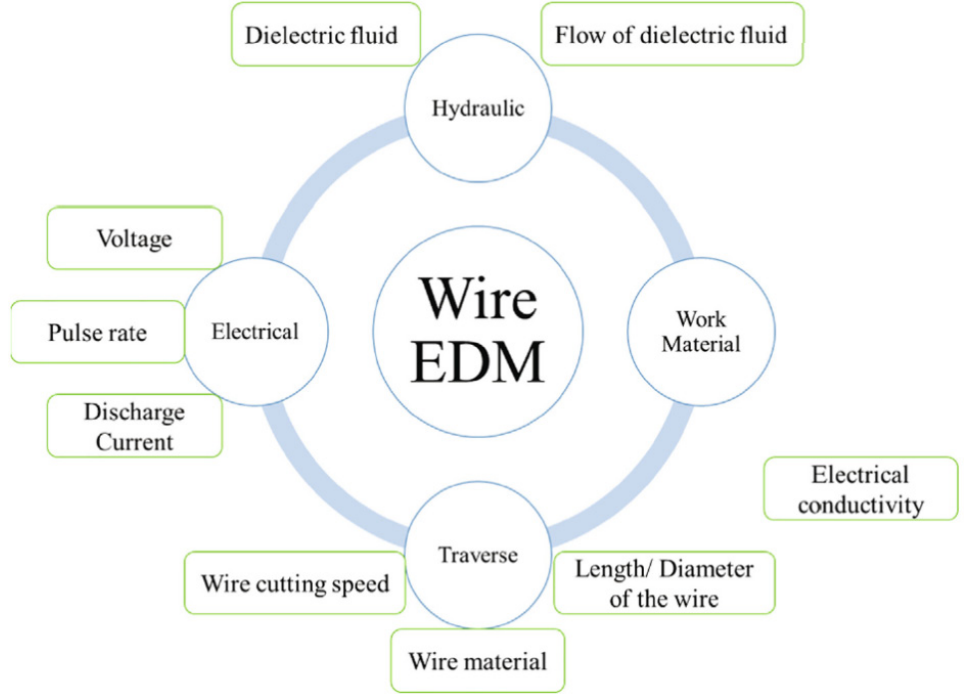
Figure 7. Parameters affecting WEDM (Reprinted with permission from Ref. [104]; 2022, copyright Elsevier Ltd.).